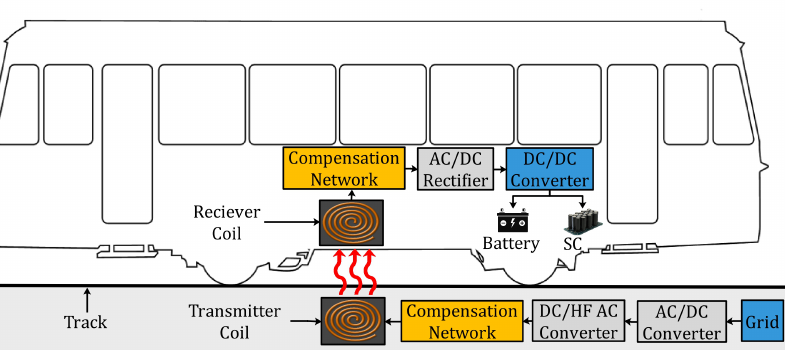
Figure 1. Wireless power transfer–hybrid energy storage system (WPT–HESS) implemented in a light rail vehicle